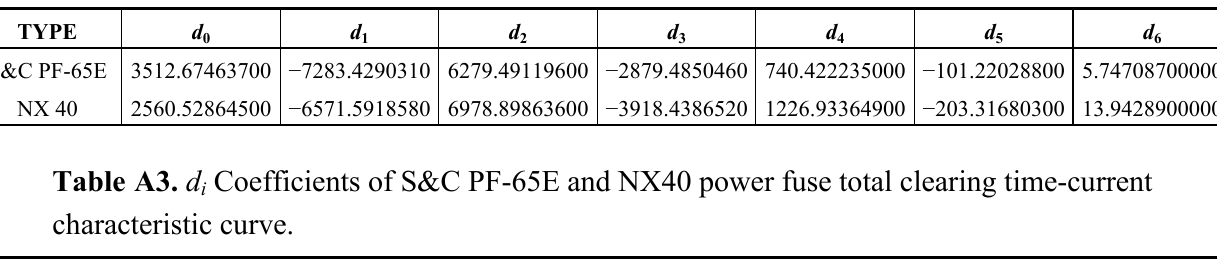
Coefficients of S&C PF-65E and NX40 power fuse minimum melting Table A2. d i time-current characteristic curve.